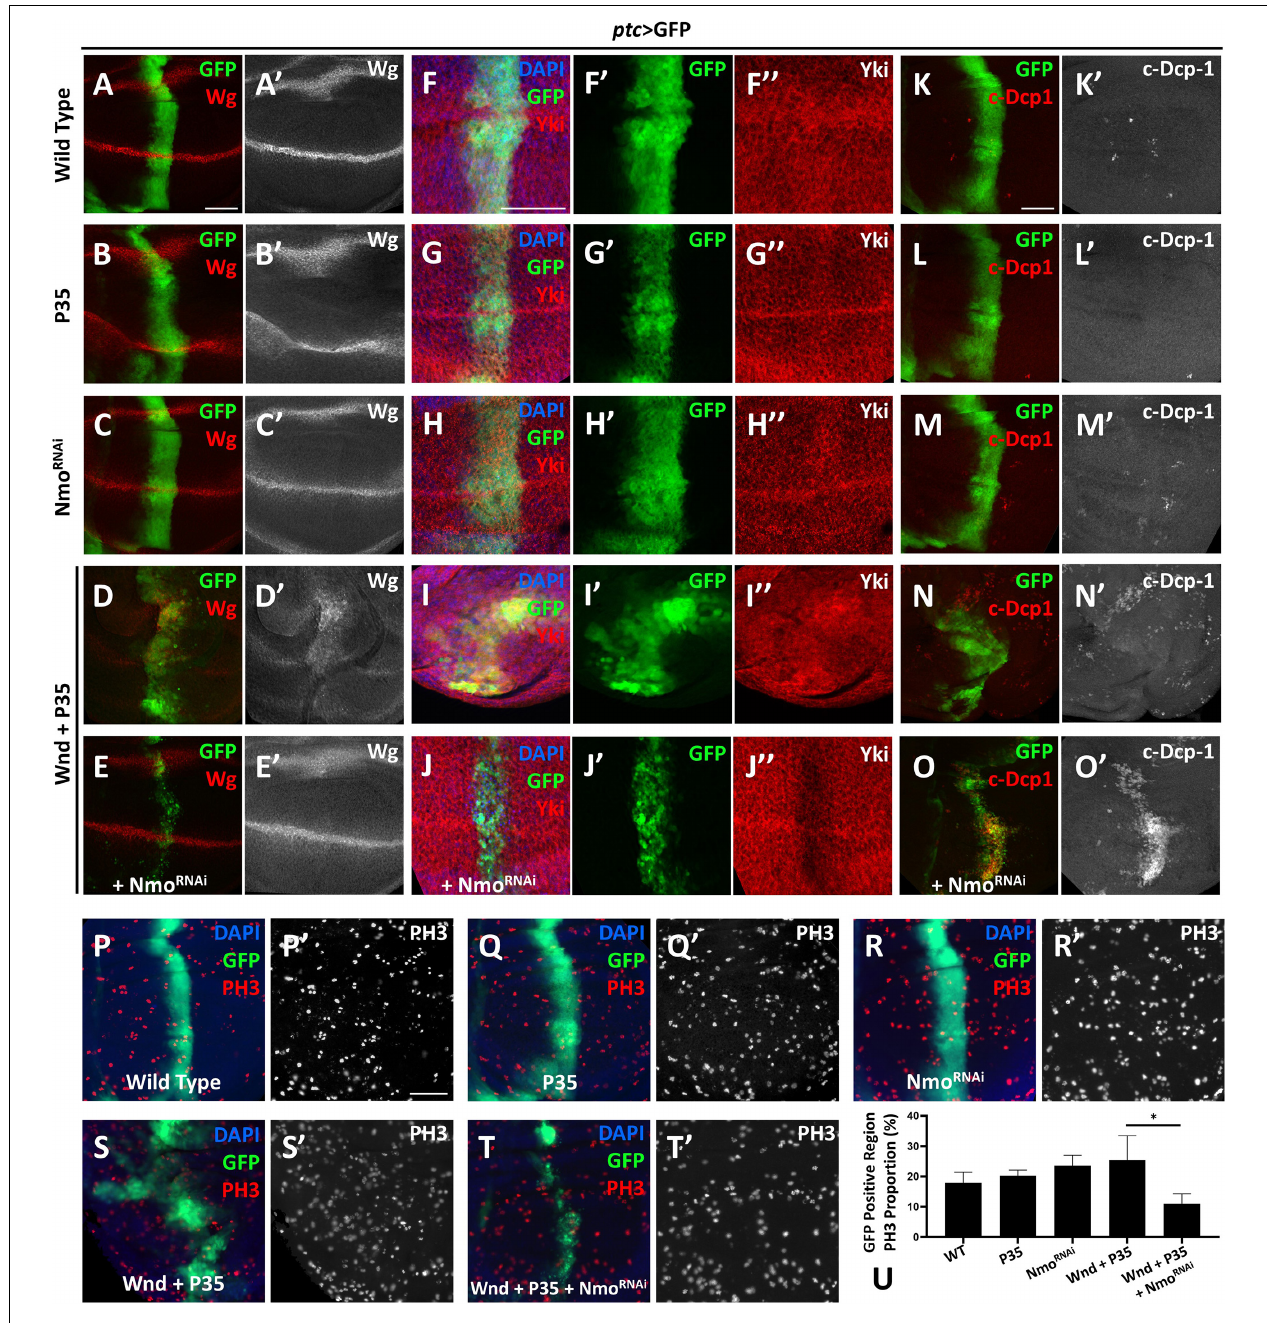
FIGURE 3 | Nmo acts genetically downstream of wnd . Wing imaginal discs from third instar larva with genes or RNAi expressed in GFP positive area driven by ptc -Gal4 are shown. (A–E (cid:48) ) Compared with wild type (A,A (cid:48) ) or P35 expression alone control (B,B (cid:48) ) , co-expression of wnd and P35 elevates Wingless (Wg) level (D,D (cid:48) ) , which is rescued by knocking down Nmo (E,E (cid:48) ) , while nmo knockdown alone shows little effect (C,C (cid:48) ) . (F–J (cid:48)(cid:48) ) Compared with wild type (F–F (cid:48)(cid:48) ) or P35 expression alone control (G–G (cid:48)(cid:48) ) , co-expression of wnd and P35 enhances Yki nuclear localization, which is completely rescued by nmo knockdown (J–J (cid:48)(cid:48) ) , while Nmo knockdown alone has little effect (H–H (cid:48)(cid:48) ) . (K–O) Compared with wild-type controls (K,K (cid:48) ) or P35 expression alone controls (L,L (cid:48) ) , co-expression of Wnd and P35 induce non-autonomous apoptosis (shown by c-Dcp-1 staining) throughout the wing disc (N,N (cid:48) ) . Although nmo knockdown alone does not affect apoptosis rate (M,M (cid:48) ) , upon Nmo knockdown under Wnd and P35 co-expression background, fewer apoptosis signals are found outside GFP positive region while severe apoptosis is detected in an autonomous manner (O,O (cid:48) ) . (P–T (cid:48) ) PH3 staining images are shown to demonstrate cell proliferation. Compared with wild type (P,P (cid:48) ) or P35 expression alone control (Q,Q (cid:48) ) , co-expression of wnd and P35 elevates cell proliferation rate (S,S (cid:48) ) , which is suppressed by knocking down nmo (T,T (cid:48) ) , while nmo knockdown alone does not show significant difference (R,R (cid:48) ) . Scale bars, 50 µ m. (U) Statistic analysis of the relative PH3 + number in panel P–T. ∗ P < 0.05 (unpaired t- test with Welch’s correction was used to calculate statistical significance mean + SD , n ≥ 4).